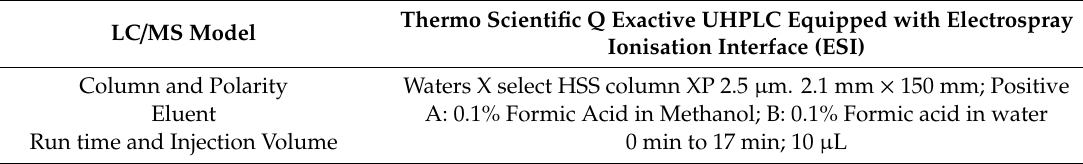
Table 3. Liquid chromatography / mass spectrometer (LC / MS) method.